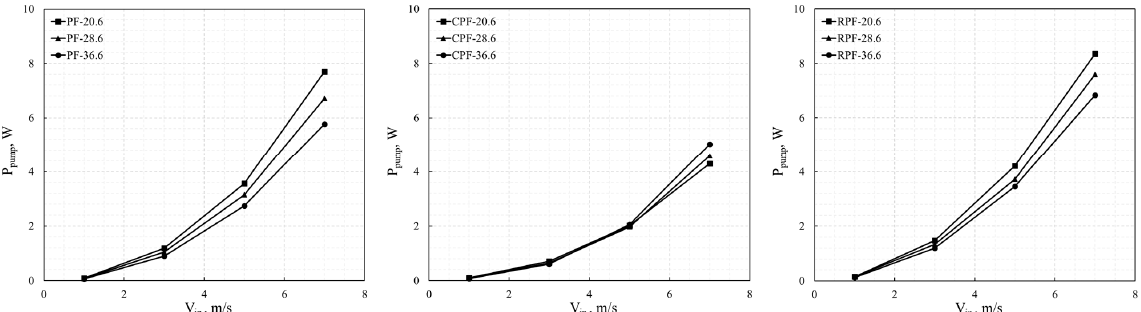
Figure 10. Pumping power for three different types of heat sink with different inlet velocities of flue gas. ( T in = 600 °C).